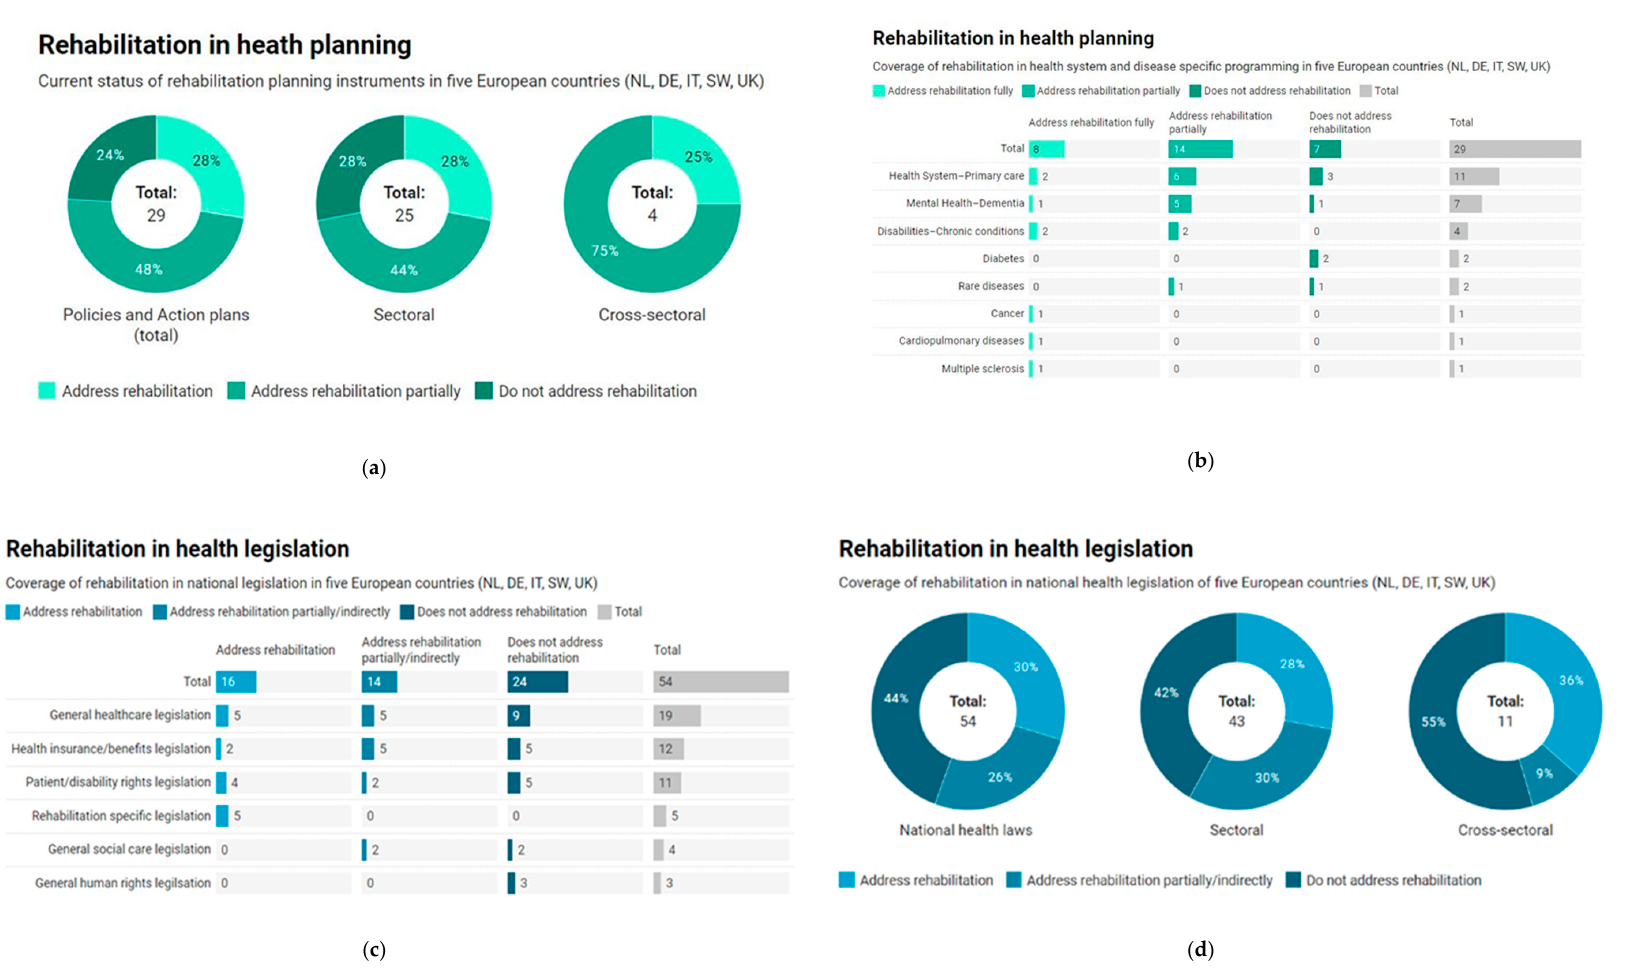
Figure 2. Coverage of rehabilitation in health law and planning instruments in five European countries (NL, DE, IT, SW, UK): ( a ) current status of rehabilitation in health planning instruments, ( b ) coverage of rehabilitation in health systems and disease specific programming instruments, ( c ) coverage of rehabilitation in national health legislation, and ( d ) coverage of rehabilitation in national legislation.